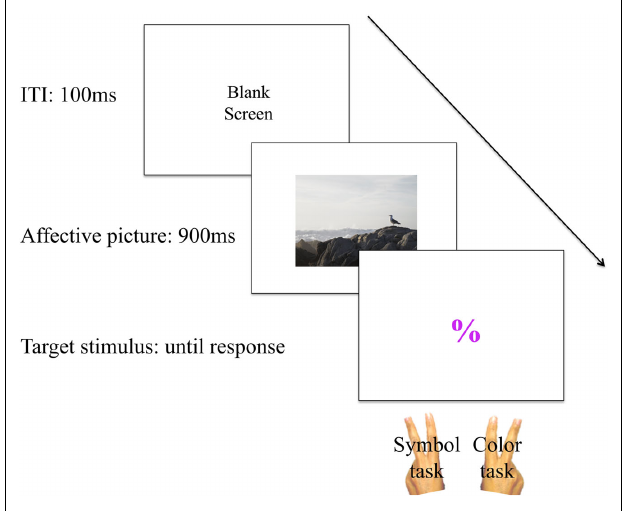
FIGURE 1 | Schematic overview of a